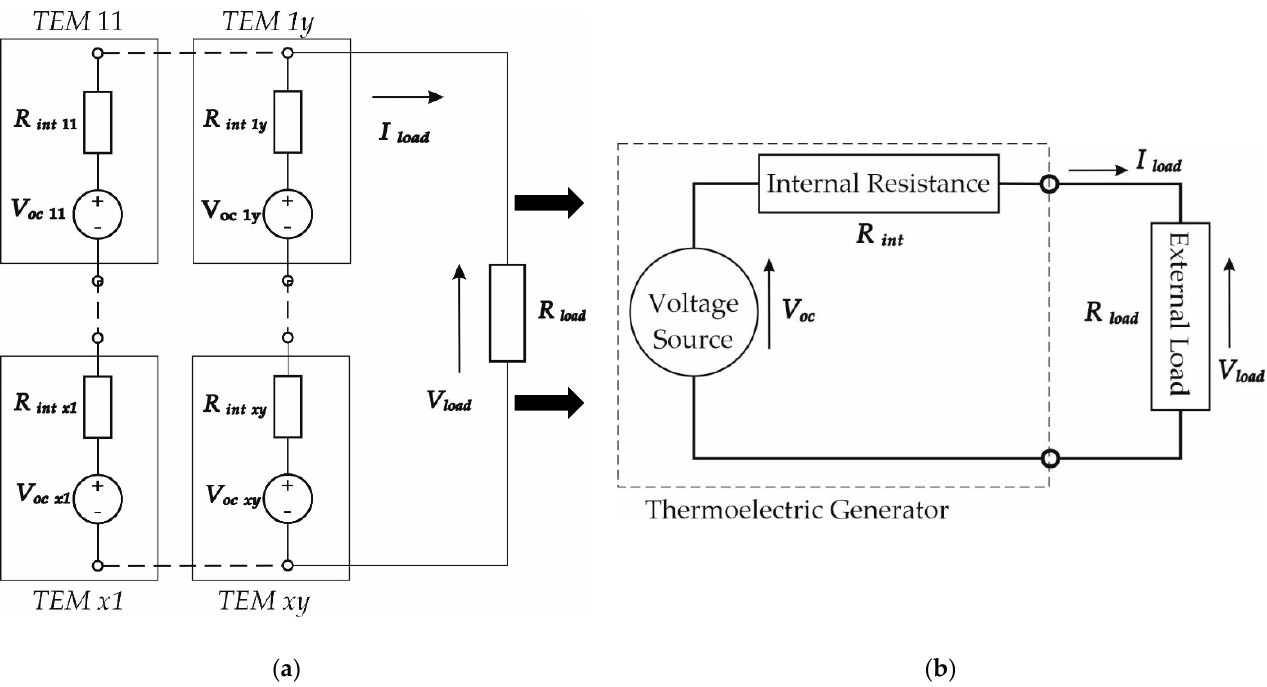
Figure 6. Electrical model diagram of TEMs: ( a ) in series–parallel configuration under heterogeneous thermal surface conditions and ( b ) its equivalent circuit.